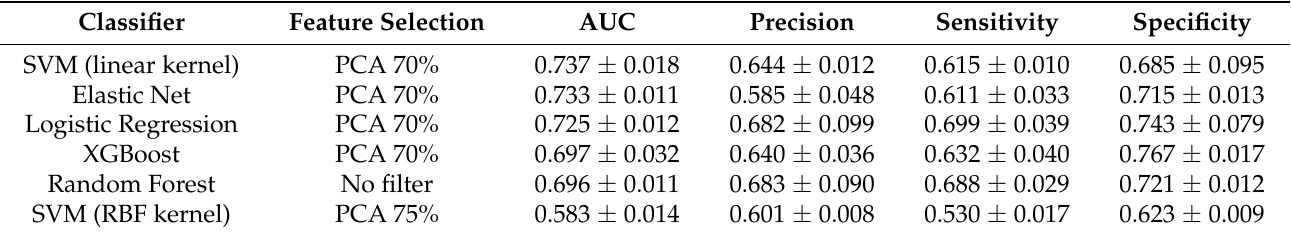
Table 2. Performance results of each classifier with the best AUC. For each combination of classifier and feature selection method, the evaluation metrics AUC, precision, sensitivity, and specificity are presented as mean ± standard deviation. AUC—Area Under the Curve; SVM—Support Vector Machine; XGBoost—Extreme Gradient Boosting; RBF—Radial Basis Function.